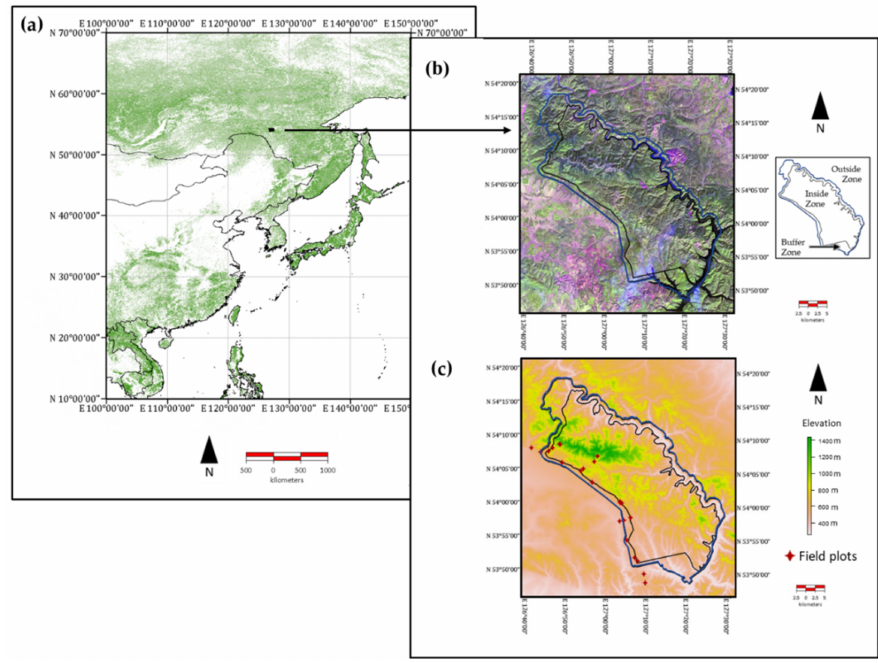
Figure 1. The study area and field plots established at Zeya State Nature Reserve. ( a ) The normalized different vegetation index (NDVI) distribution map of East Asia. ( b ) Zeya State Nature Reserve. ( c ) The study area elevation (m) and field